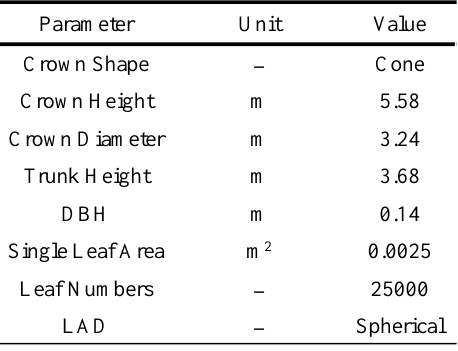
, 𝑓 , 𝑓 ) retrieved by 𝑖𝑠𝑜 𝑣𝑜𝑙 𝑔𝑒𝑜